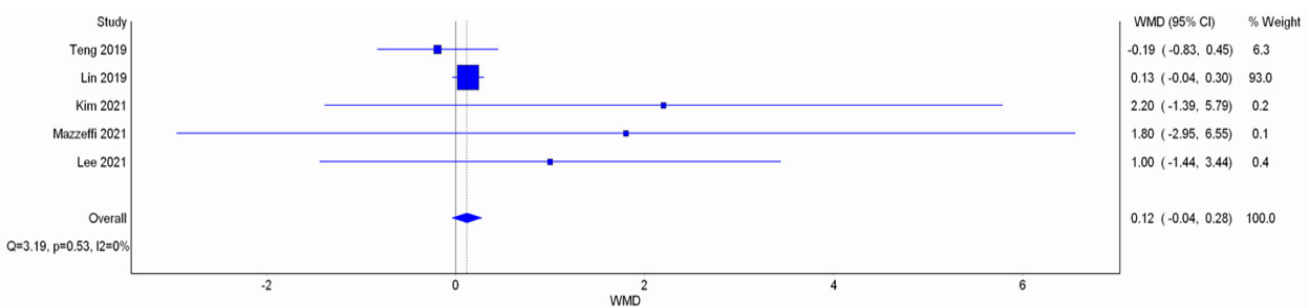
Figure A9. Meta-analysis with IVhet model: duration of procedure. Studies included: Teng et al. [12],